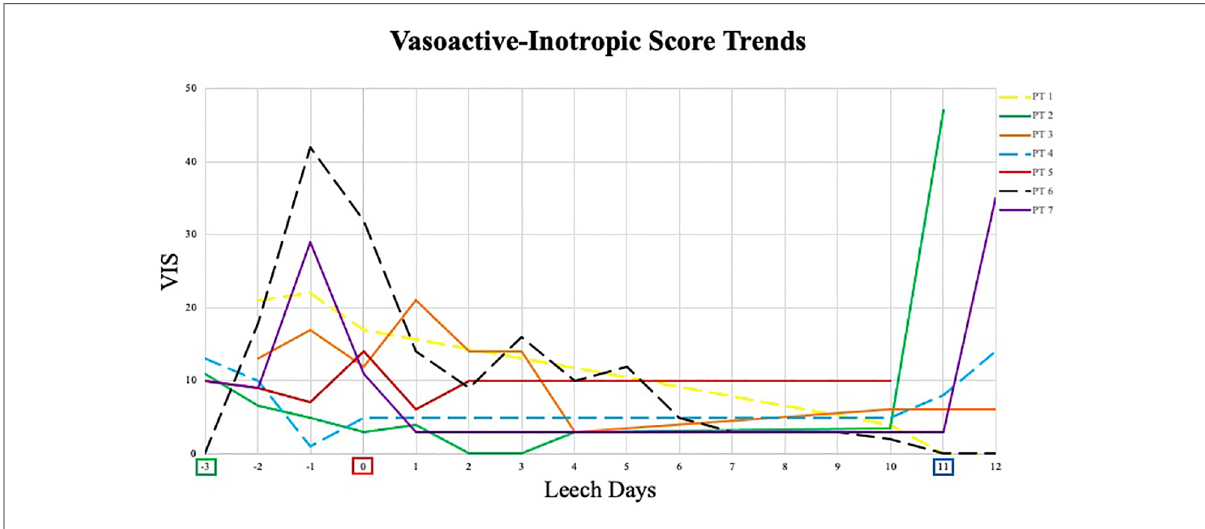
FIGURE 1 Vasoactive-inotropic score trends. Begin Pre-Leech Phase. begin leech phase. begin post-leech phase. VIS, vasoactive-inotropic score; PT, patient; ---, surviving patient; — , deceased patient. Of note, leech phase duration was not uniform in all patients; lines were made continuous for clarity of trends – see Table 3 for individual leech